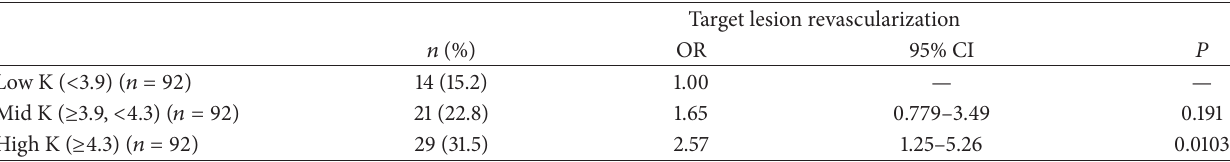
Table 5: Target lesion revascularization according to potassium